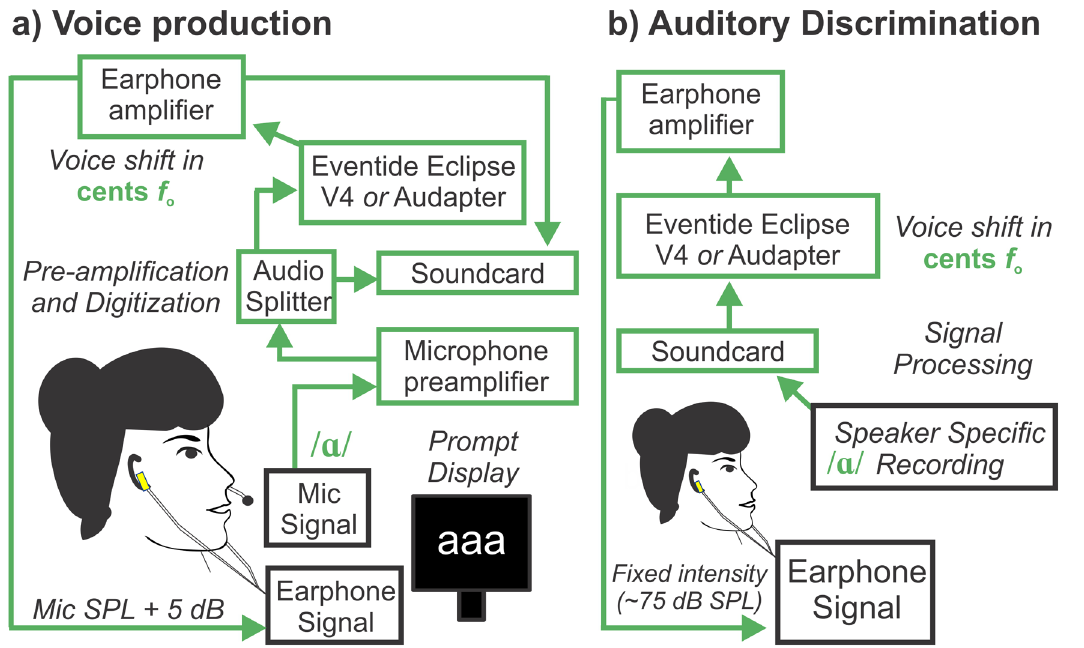
Figure 4. Experimental setup. Hardware and software setup are shown for the voice production (panel a ) and auditory discrimination (panel b ) tasks involving shifts in auditory feedback of fundamental frequency ( f o ) in cents (100 cents = 1 semitone). Voice production tasks consisted of speakers actively producing an/ ɑ /vowel, with prompts on a computer display, during f o perturbations in auditory feedback administered with a 5 dB increase in sound pressure level (SPL) relative to the microphone (mic) signal. The auditory discrimination task consisted of making judgments by listening to shifts in voice f o played back at a set level of 75 dB